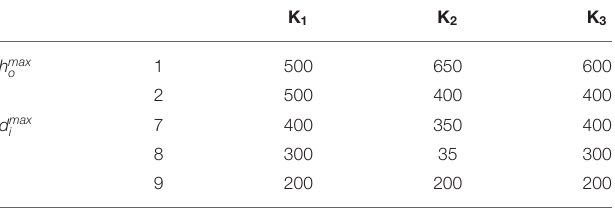
TABLE 4 | Emergency supplies information.